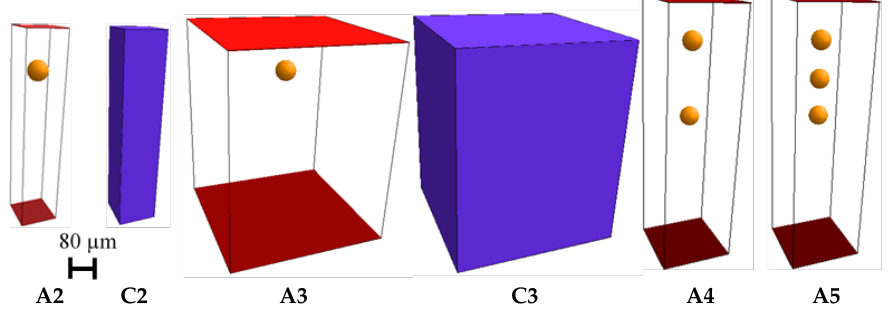
Figure 7. ( A2 ) from model A1 which is reduced in width, with periodic boundaries, ( C2 ) from model C1 which is reduced in width, with solid wall boundaries, ( A3 ) from model A1 which is enlarged in width, with periodic boundaries, ( C3 ) from model C1 which enlarged in width, with solid wall boundaries, ( A4 ) from model A1 which is enlarged in height and one added particle, with periodic boundaries, ( A5 ) from model A1 which is enlarged in height and two added particles, with periodic boundaries.